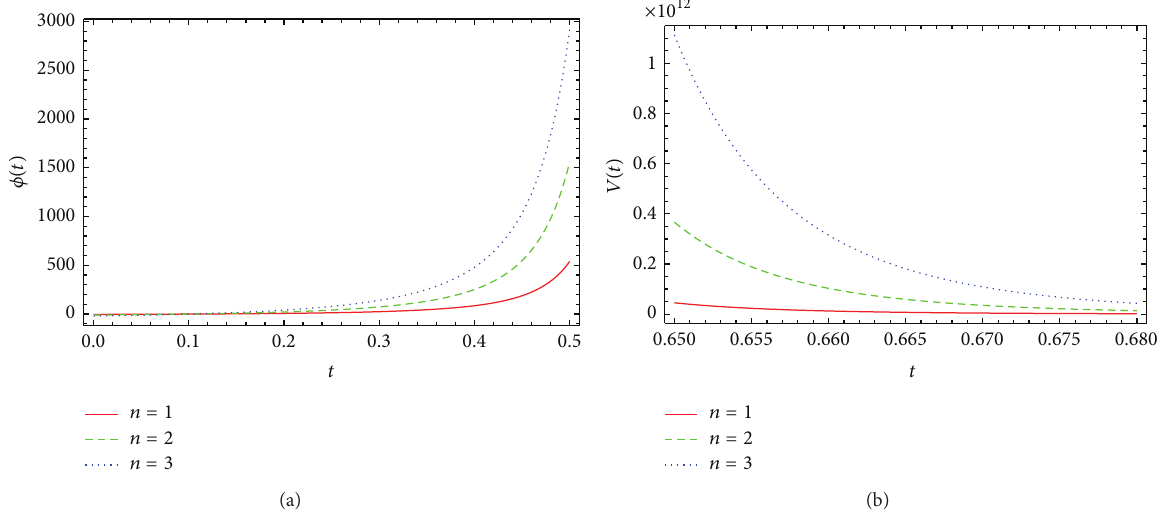
Figure 9: Plots of 𝑓(𝑅,∇𝑅) DBI-essence scalar field (with constant 𝛾 ): (a) 𝜙 versus cosmic time 𝑡 and (b) potential versus 𝑡 for 𝑛 = 1 (red), 𝑛 = 2 (green), and 𝑛 = 3 (blue).